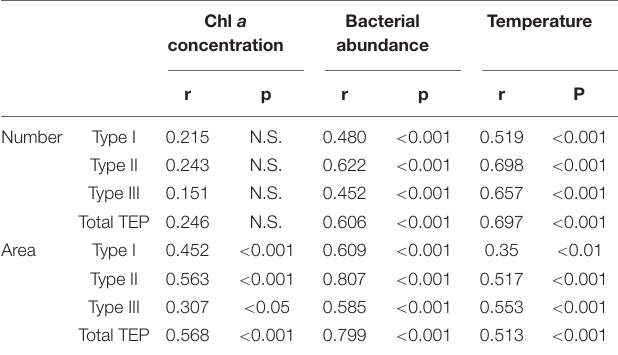
TABLE 3 | Pearson’s correlation (r) between transparent exopolymer particle (TEP) abundance (number and area) and environmental variables (Chl a concentration, bacterial abundance, and temperature), after logarithmic transformation, except for